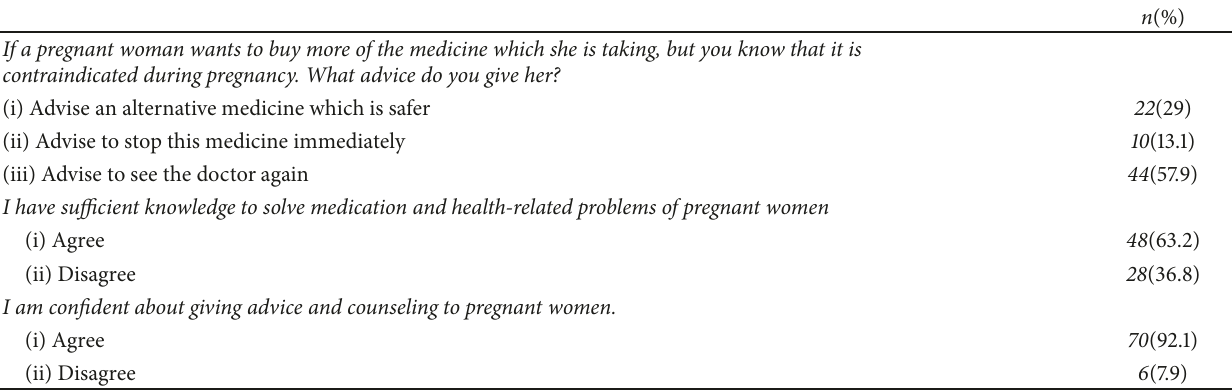
Table 6: Practice of pharmacy professionals about contraindicated medicines in